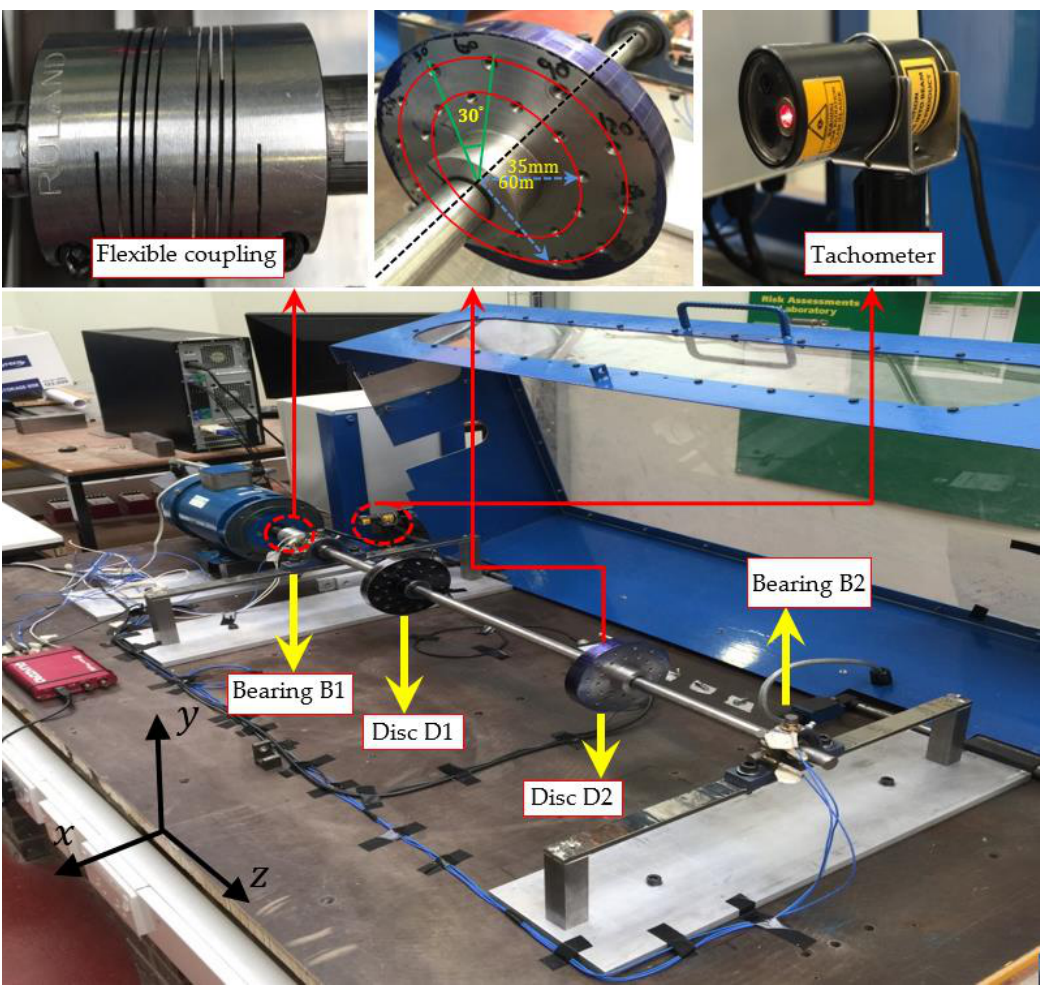
Figure 1. Mechanical layout of the experimental rig.